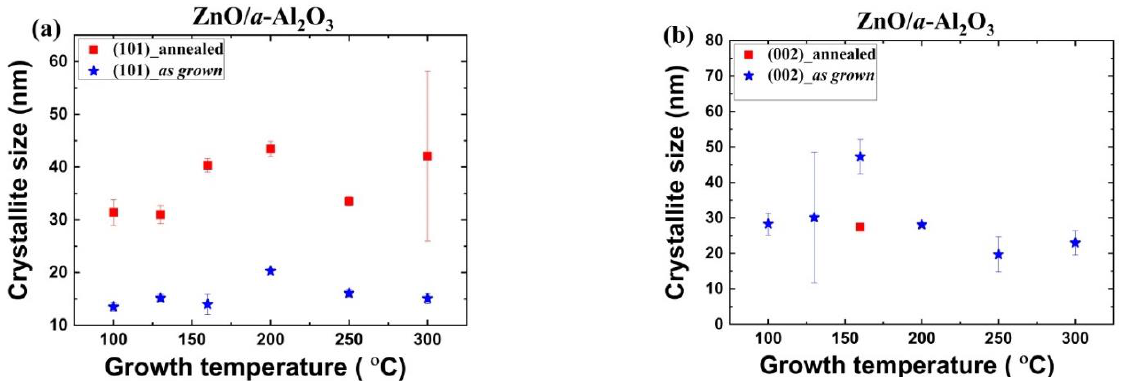
Figure 5. The size of crystallites oriented along ( a ) the [101] and ( b ) [001] direction for ZnO/a-Al 2 O 3 films.